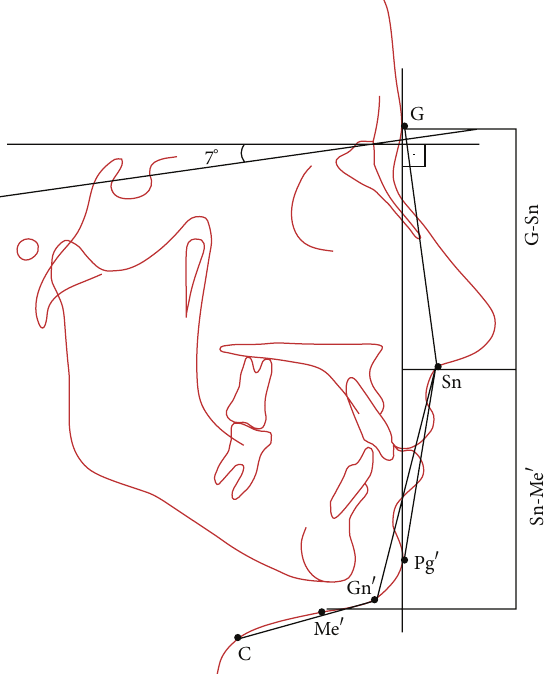
Figure 1: Legan-Burstone soft tissue analysis: facial forms. Hori- zontal reference plane (HP), constructed by drawing a line through nasion (N) 7 degrees up from the sella-nasion line. Facial convexity angle (G-Sn-Pg 󸀠 ); maxillary prognathism (G vertical-Sn); mandibu- lar prognathism (G vertical-Pg 󸀠 ); vertical height ratio (G-Sn/Sn- Me 󸀠 ); lower face-throat angle (Sn-Gn 󸀠 -C); lower vertical height- depth ratio (Sn-Gn 󸀠 /C-Gn 󸀠 ).